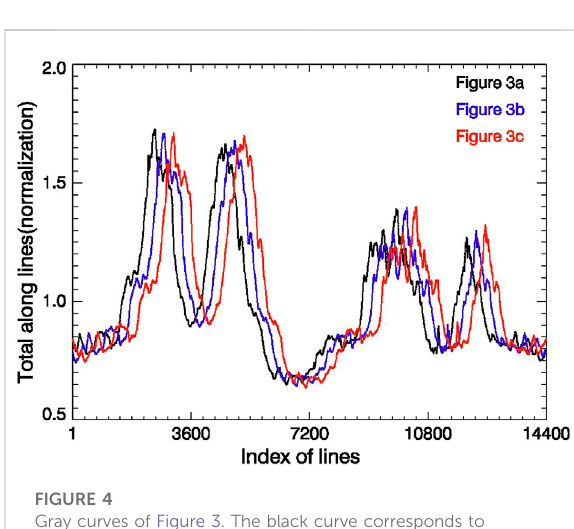
FIGURE 4 Gray curves of Figure 3. The black curve corresponds to Figure 3A, the blue curve corresponds to Figure 3B, and the red curve corresponds to Figure 3C. The abscissa represents the serial number of the line, and the ordinate represents the sum of gray values along the